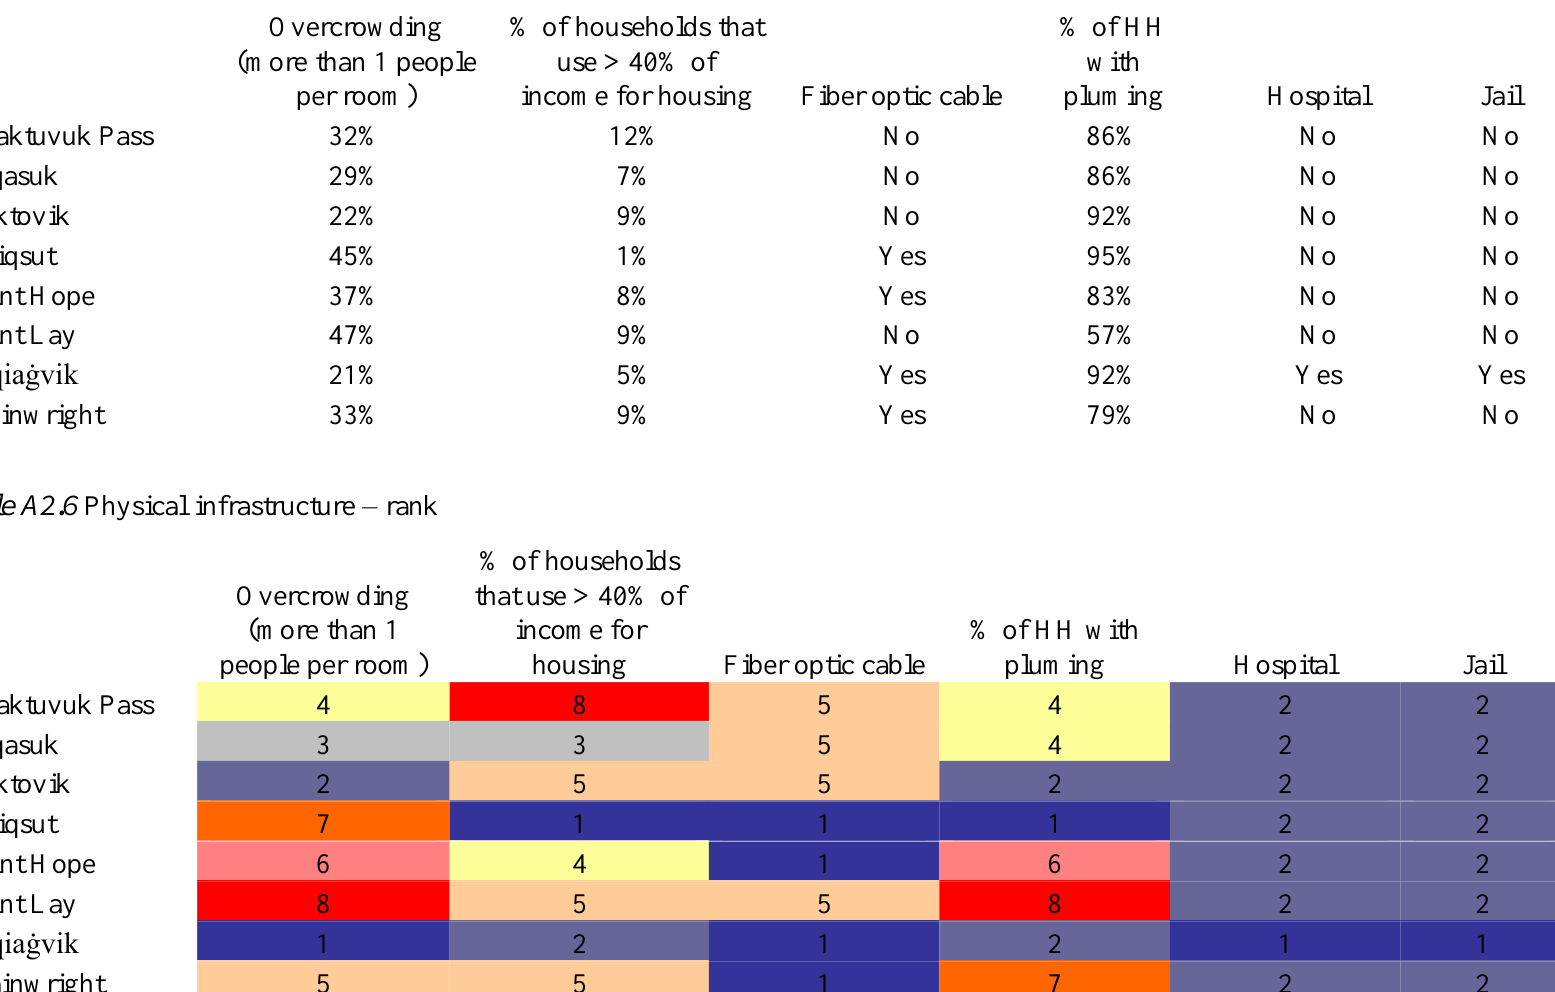
Table A2.5 Physical infrastructure – data